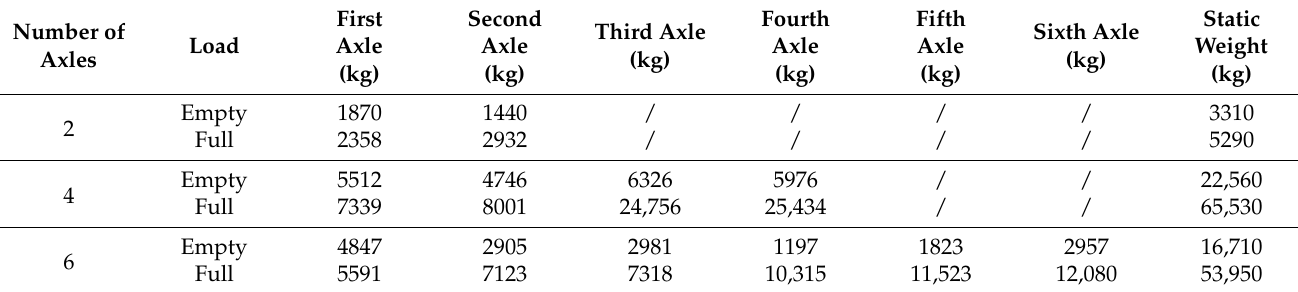
Table 1. Data from three test vehicles.